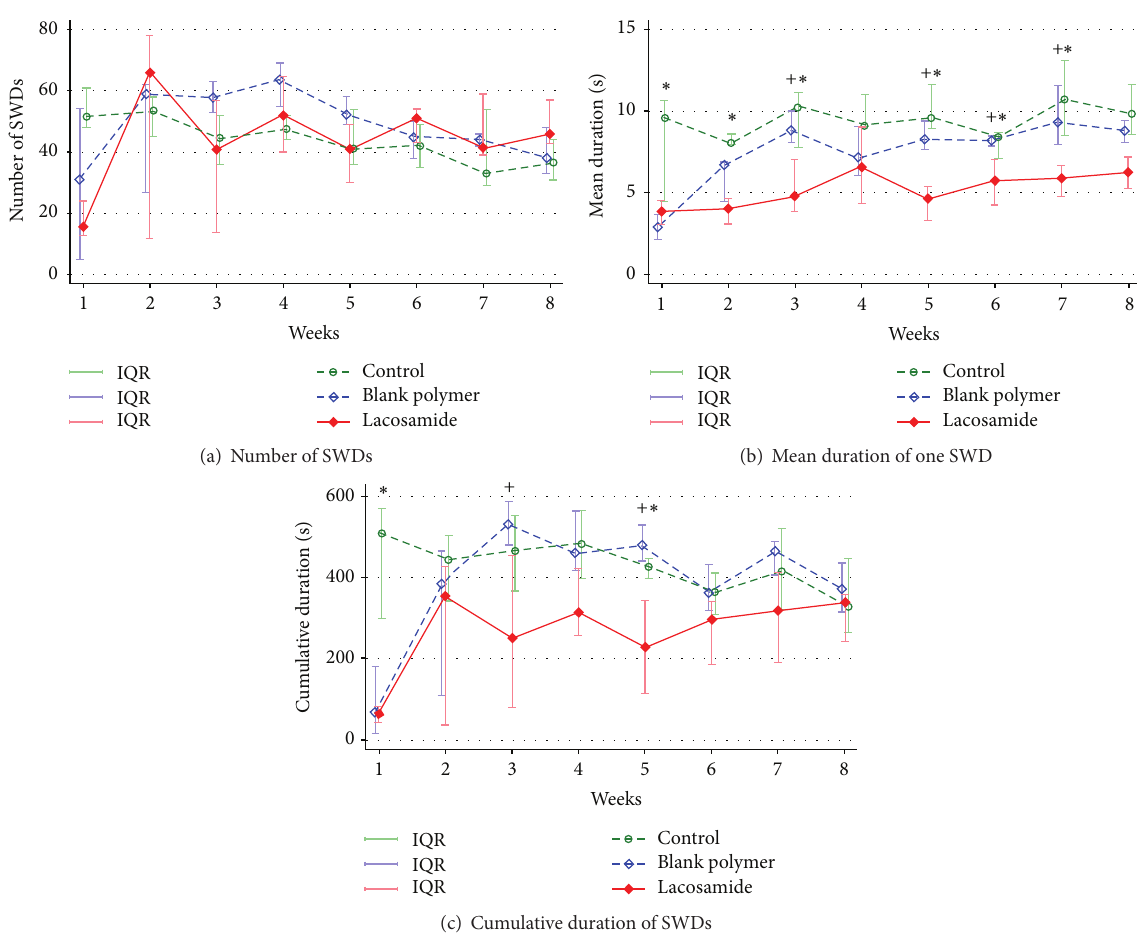
Figure 4: Comparison of the measurements obtained to evaluate the epileptic activity of groups control ( 𝑛 = 6 ), blank polymer ( 𝑛 = 6 ), and lacosamide polymer ( 𝑛 = 6 ). SWD: spike-and-wave discharge; IQR: interquartile range; results are reported as median. ∗ and + represent the time points at which the results from the lacosamide polymer group were significantly different to the control and blank polymer groups, respectively ( 𝑝 < 0.05